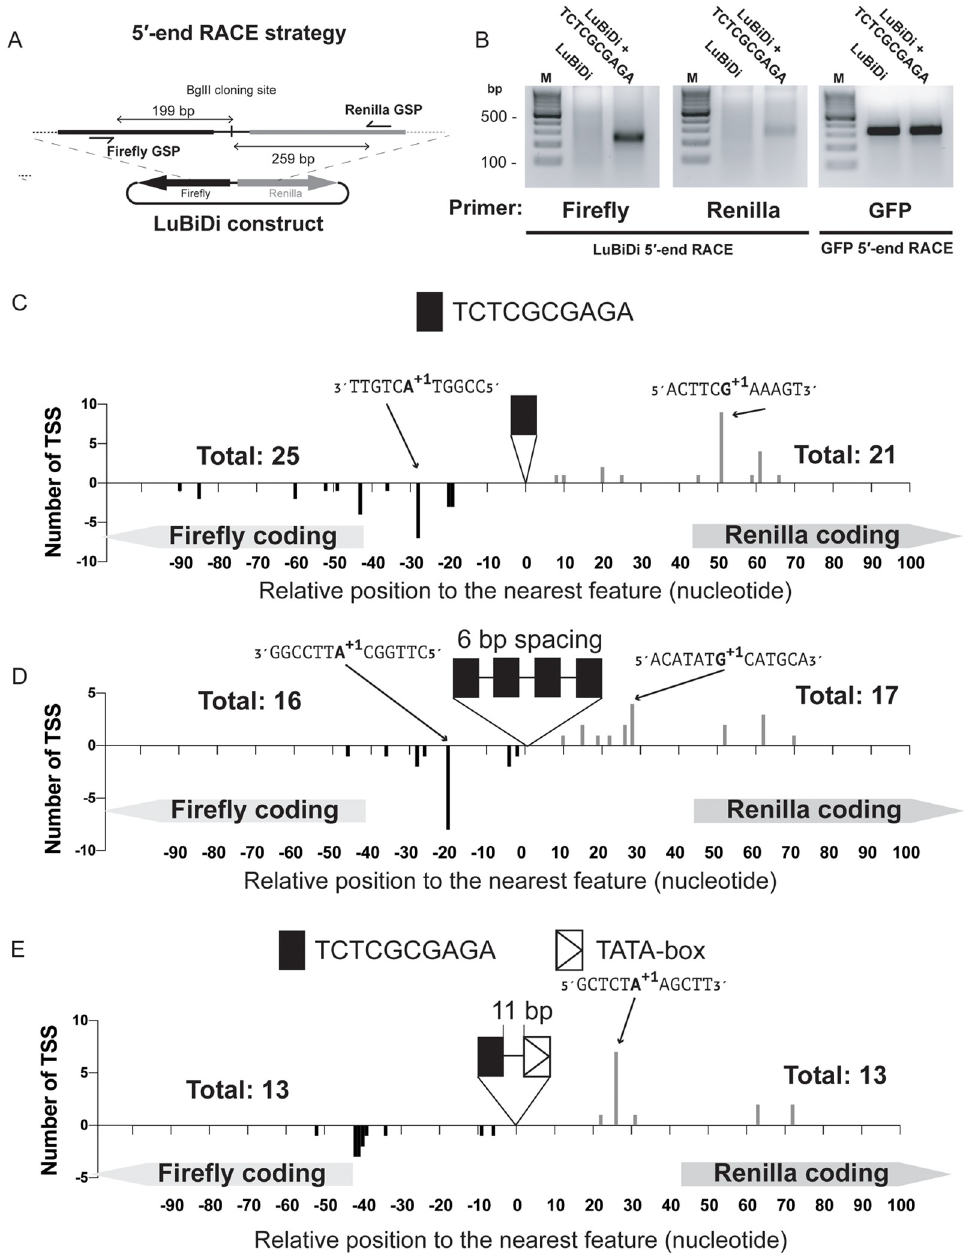
Fig 6. CGCG element is associated with divergent transcription start sites. A) The location of gene-specific primers used in 5 0 -RACE experiments to identify bidirectional TSSs in the LuBiDi based reporter constructs. Firefly and Renilla luciferase primers were designed 199 and 259 bp away from the BglII cloning site, respectively. B) Agarose gel image of firefly and Renilla luciferase RACE PCR products for the LuBiDi constructs containing none or one copy of TCTCGCGAGA. GFP transcripts were used as an internal control for RACE. C) TSS were determined for the LuBiDi construct containing a single copy of the TCTCGCGAGA motif. The sequence of +1 nucleotide and flanking five nucleotides are also shown on major TSSs. D) Bidirectional TSS associated with the LuBiDi construct containing four tandem copies of TCTCGCGAGA. E) Divergent TSS for the LuBiDi construct that contained a TATA-box and a CGCG element from the PRDX1 promoter. TSS positions are indicated in nucleotide relative to the nearest feature (the CGCG element or the TATA-box). The number of sequenced clones for each reporter constructs are indicated above coding